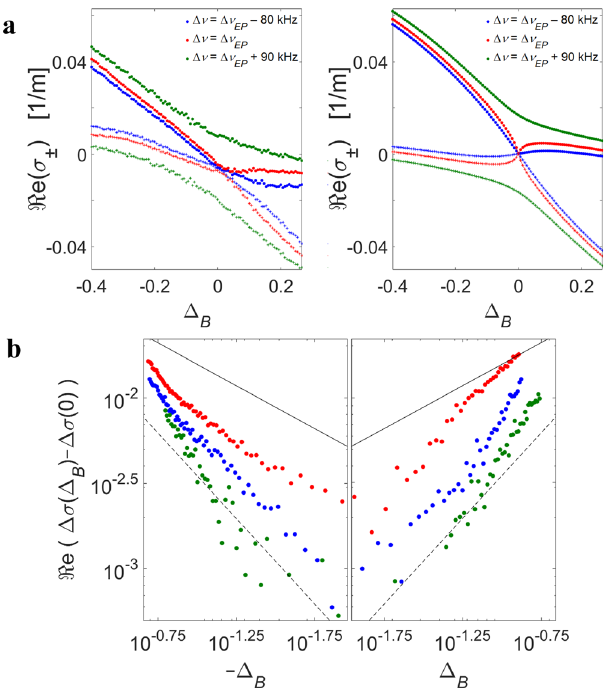
Fig. 4 Topological encircling of EP by detuning from the BFS. a ℜ e (left) Fig. 3 Enhanced sensitivity of the eigenvalues to deviations from the BFS and ℑ m (right) parts of the eigenvalues of the system σ + (red) and σ − at the EP. a Measured (left) and calculated (right) ℜ e of the eigenvalues σ ± (blue), as a function of the offset Δ B from the BFS and the ratio between as a function of small offsets from the BFS. The frequency detuning detuning and coupling 2 f Δ k = g . The means of the two eigenvalues have been between the two probe tones was adjusted above the EP (green, anti-PT- subtracted for convenience. The solid black line denotes the clockwise symmetric regime), at the EP (red), or below the EP (blue, broken- trajectory of σ + , showing the swap with σ - after one round trip. b Traces of symmetry regime), see legends. The real parts of the eigenvalues repel real and imaginary parts of the experimentally measured eigenvalues as the each other at the anti-PT-symmetric regime and coalesce at the Brillouin frequency difference between probes Δ v and offset of the probes from the resonance when the symmetry is broken. b Measured changes in the Brillouin resonance Δ v B are varied around the EP. The solid and dotted black splitting of eigenvalues as a function of normalized detuning from the BFS: (cid:9) (cid:10) (cid:11) (cid:12) lines denote the clockwise trajectories of σ + and σ − , respectively. The ℜ e Δ σ Δ (cid:1) Δ σ 0 ð Þ (logarithmic scale). The colours follow the same eigenvalues swap after one round trip. B legend as in (a). The response is the largest when Δ v approaches Δ v EP (red dots). The logarithmic slope at the EP is smaller than the slopes obtained for Δ v below (blue dots) or above (green dots) the EP. The solid and dotted black lines mark the square root and linear dependence of the splitting on Δ B /2,